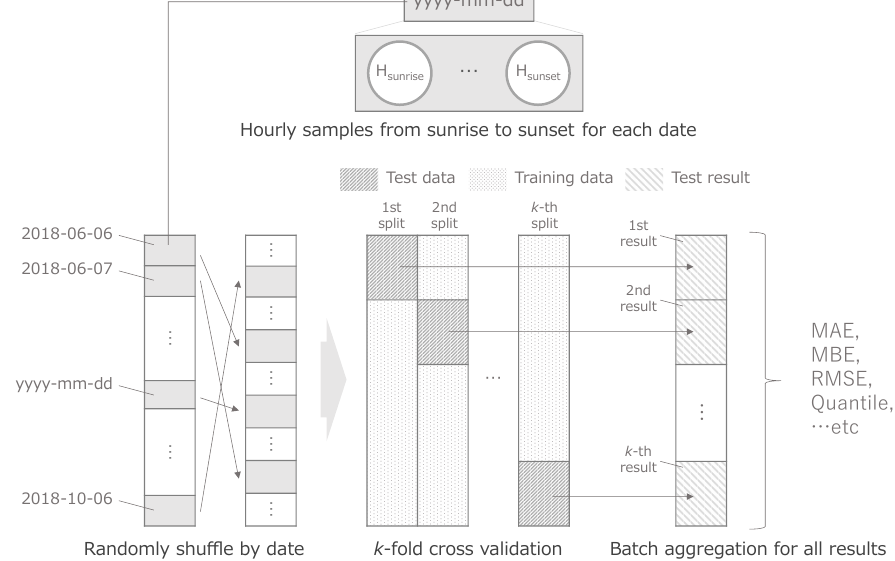
Figure 7. Structure FL of the evaluation process. Shuffle the dataset FL by the date before the CV process FL, and finally aggregate the FL prediction results together